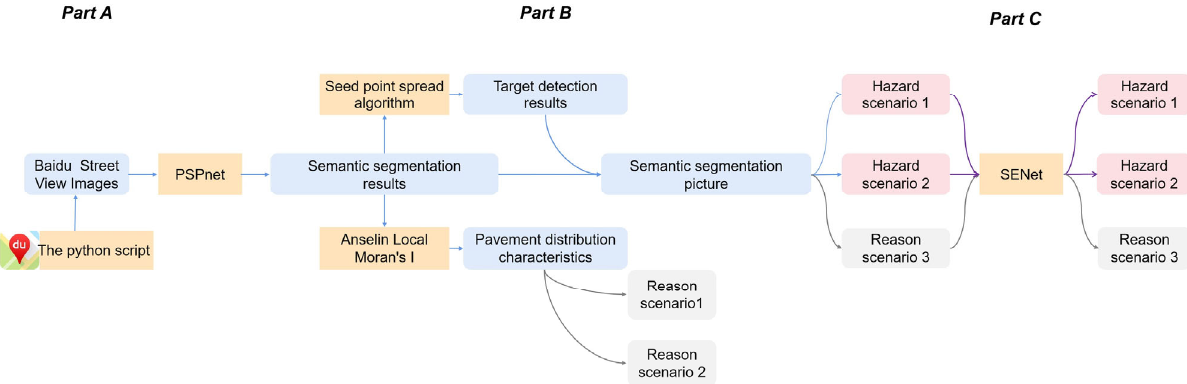
Figure 4. The framework of this